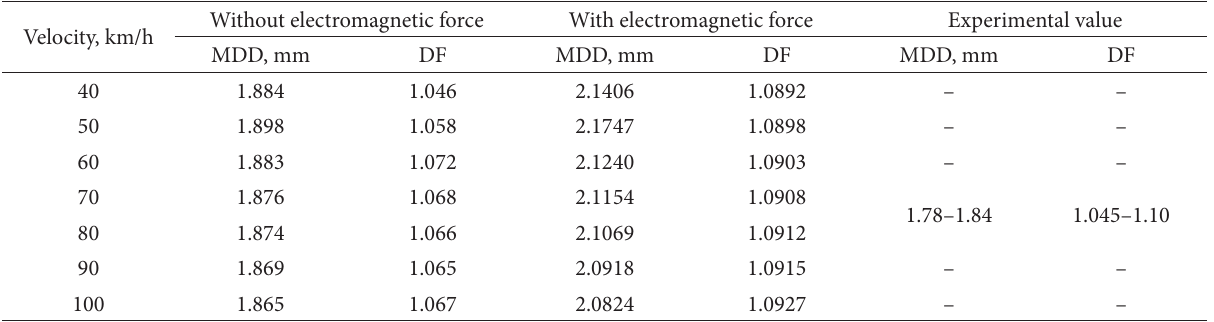
Table 3. Comparison of theoretical and experimental dynamic responses Velocity, km/h